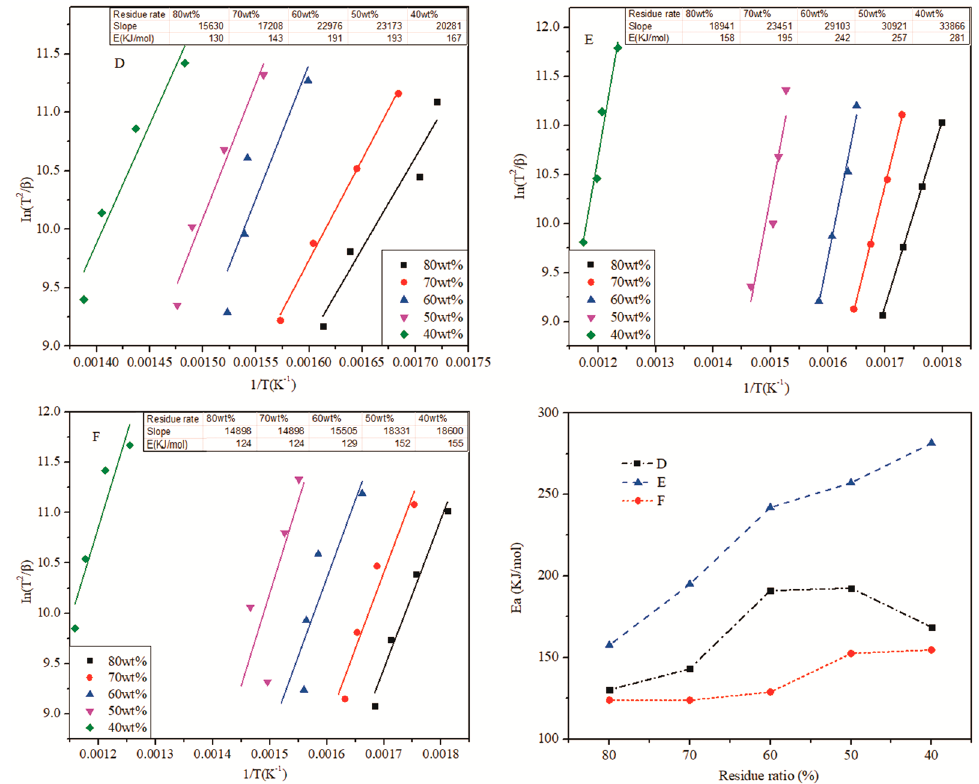
Figure 13. Decomposition activation energy of HPN-EPPA-UR-PA resin and its variation trend under different residue rates, D: 10 wt% urea; E: 5 wt% urea; F: